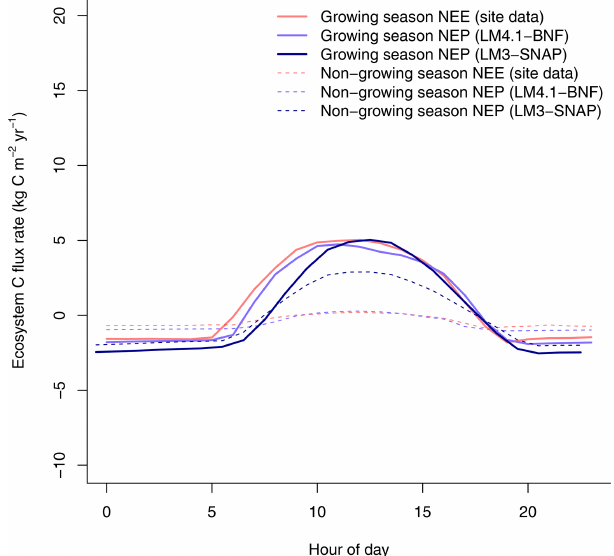
Figure 7. Simulated net ecosystem production (NEP) by LM4.1- BNF and LM3-SNAP compared to net ecosystem exchange (NEE) CHL site data at the hourly timescale. Simulated data are averaged over the last 100 of the 300 years of simulation to reflect the data which are from mature forests.